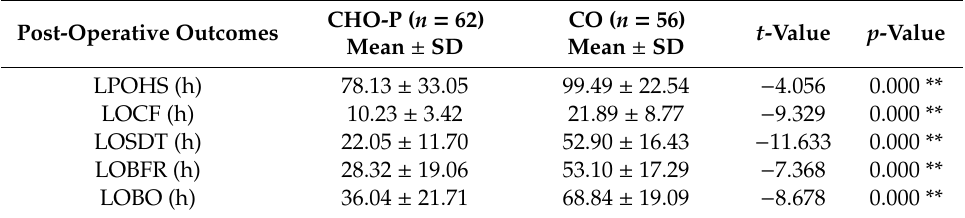
Table 5. Comparison of postoperative outcomes of surgical gynecologic cancer (GC) between intervention (CHO-P) and control groups (CO).